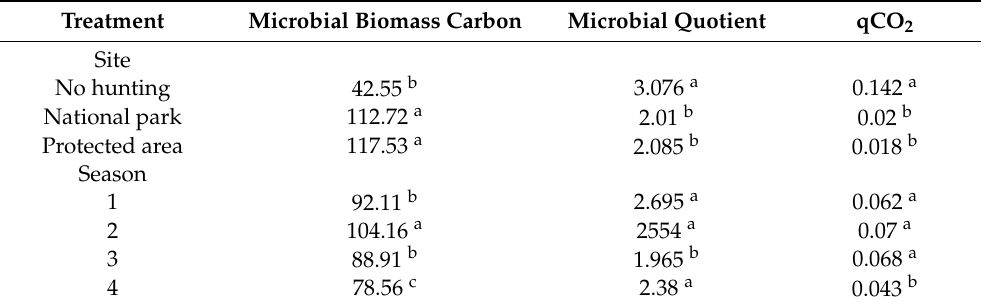
Table 6. Comparison of means for the main effects of grazing managements and season